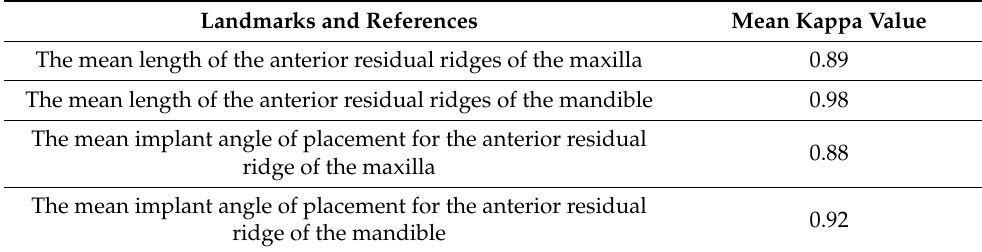
Table 2. The intra-examiner agreement for all landmarks and